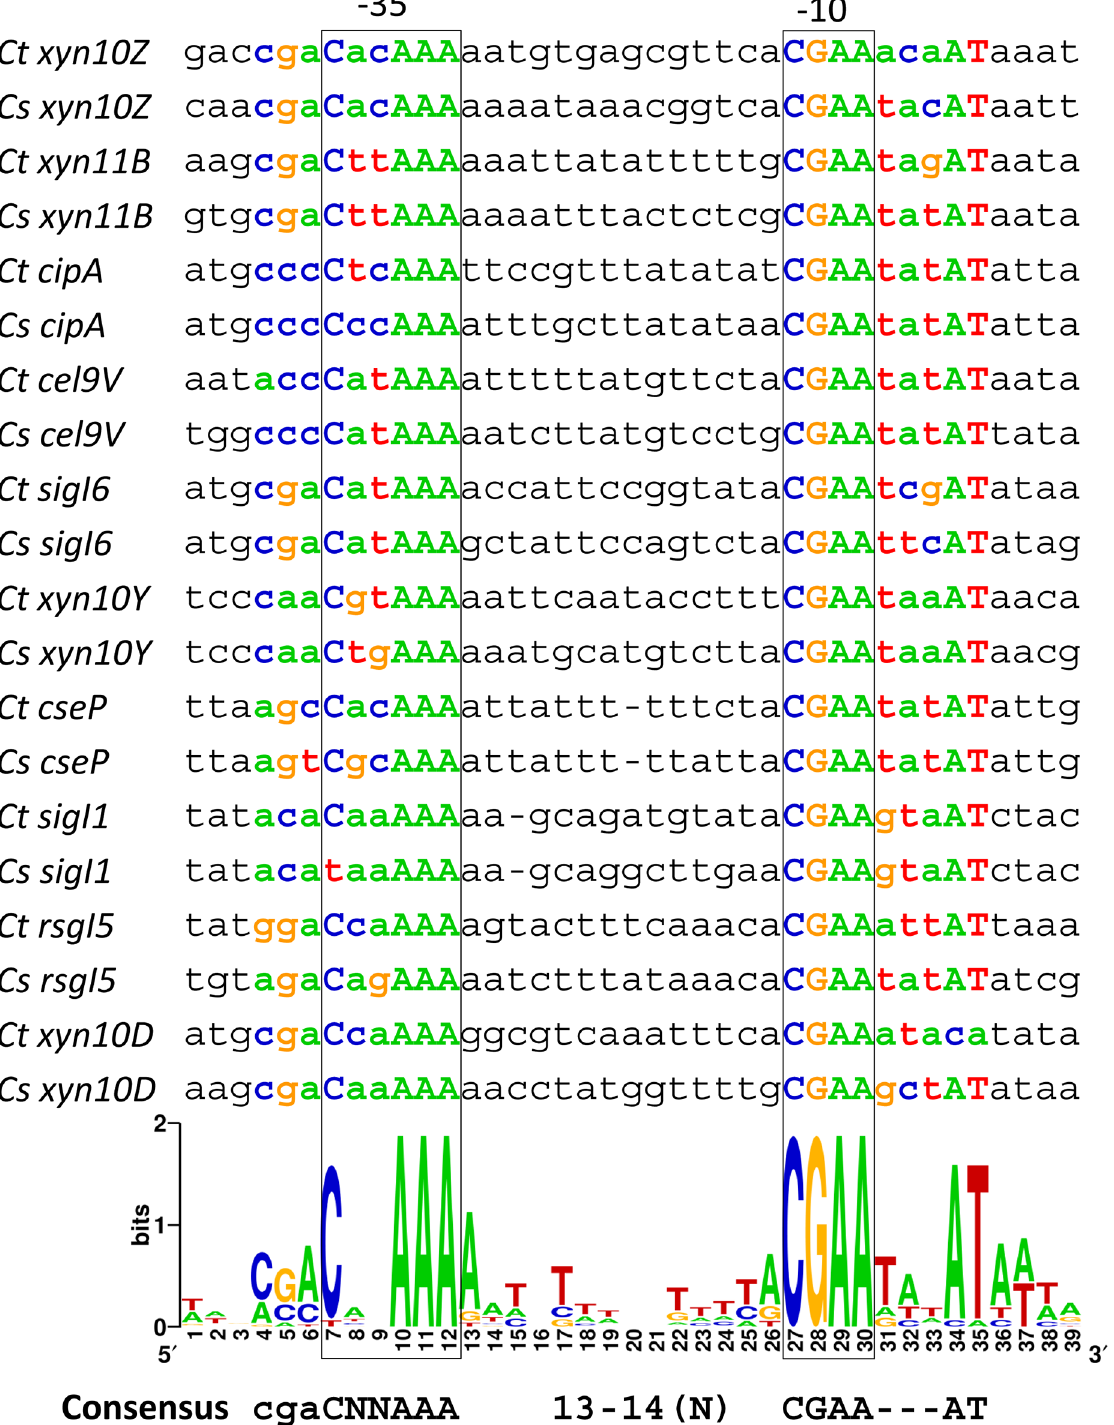
Fig 2. Identification of conserved elements of σ I6 -dependent promoter sequences. WebLogo generated with σ I6 -dependent promoter sequences of C . thermocellum and orthologous promoter sequences of C . straminisolvens .